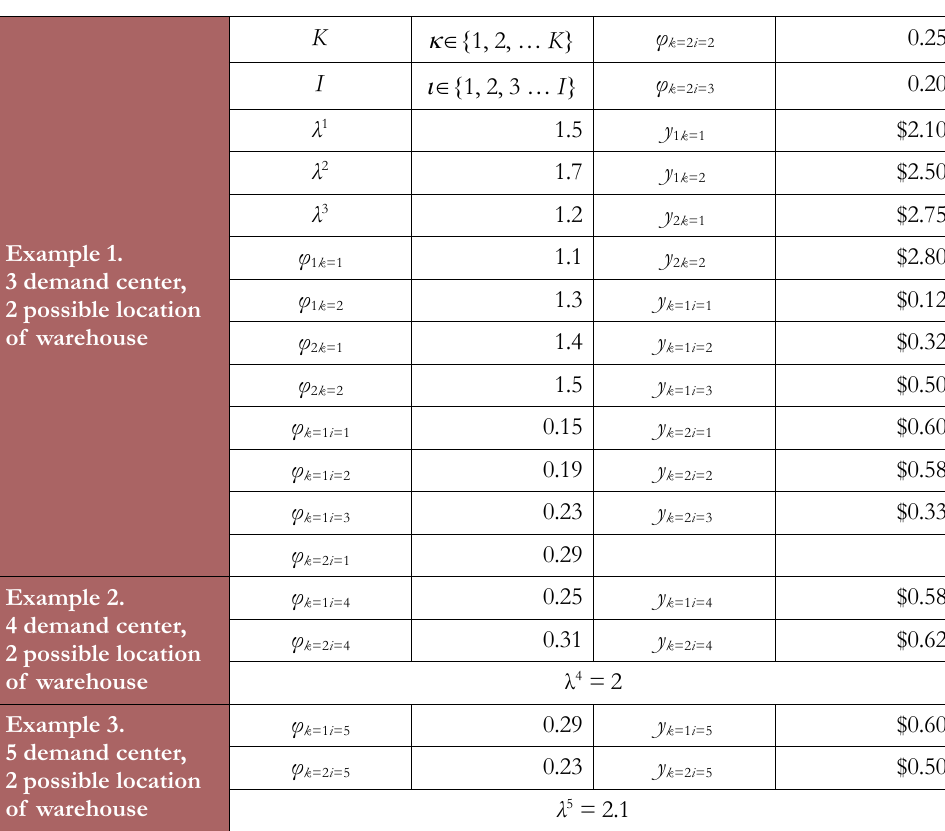
Table 4. Examples: demand centers and possible location of warehouse